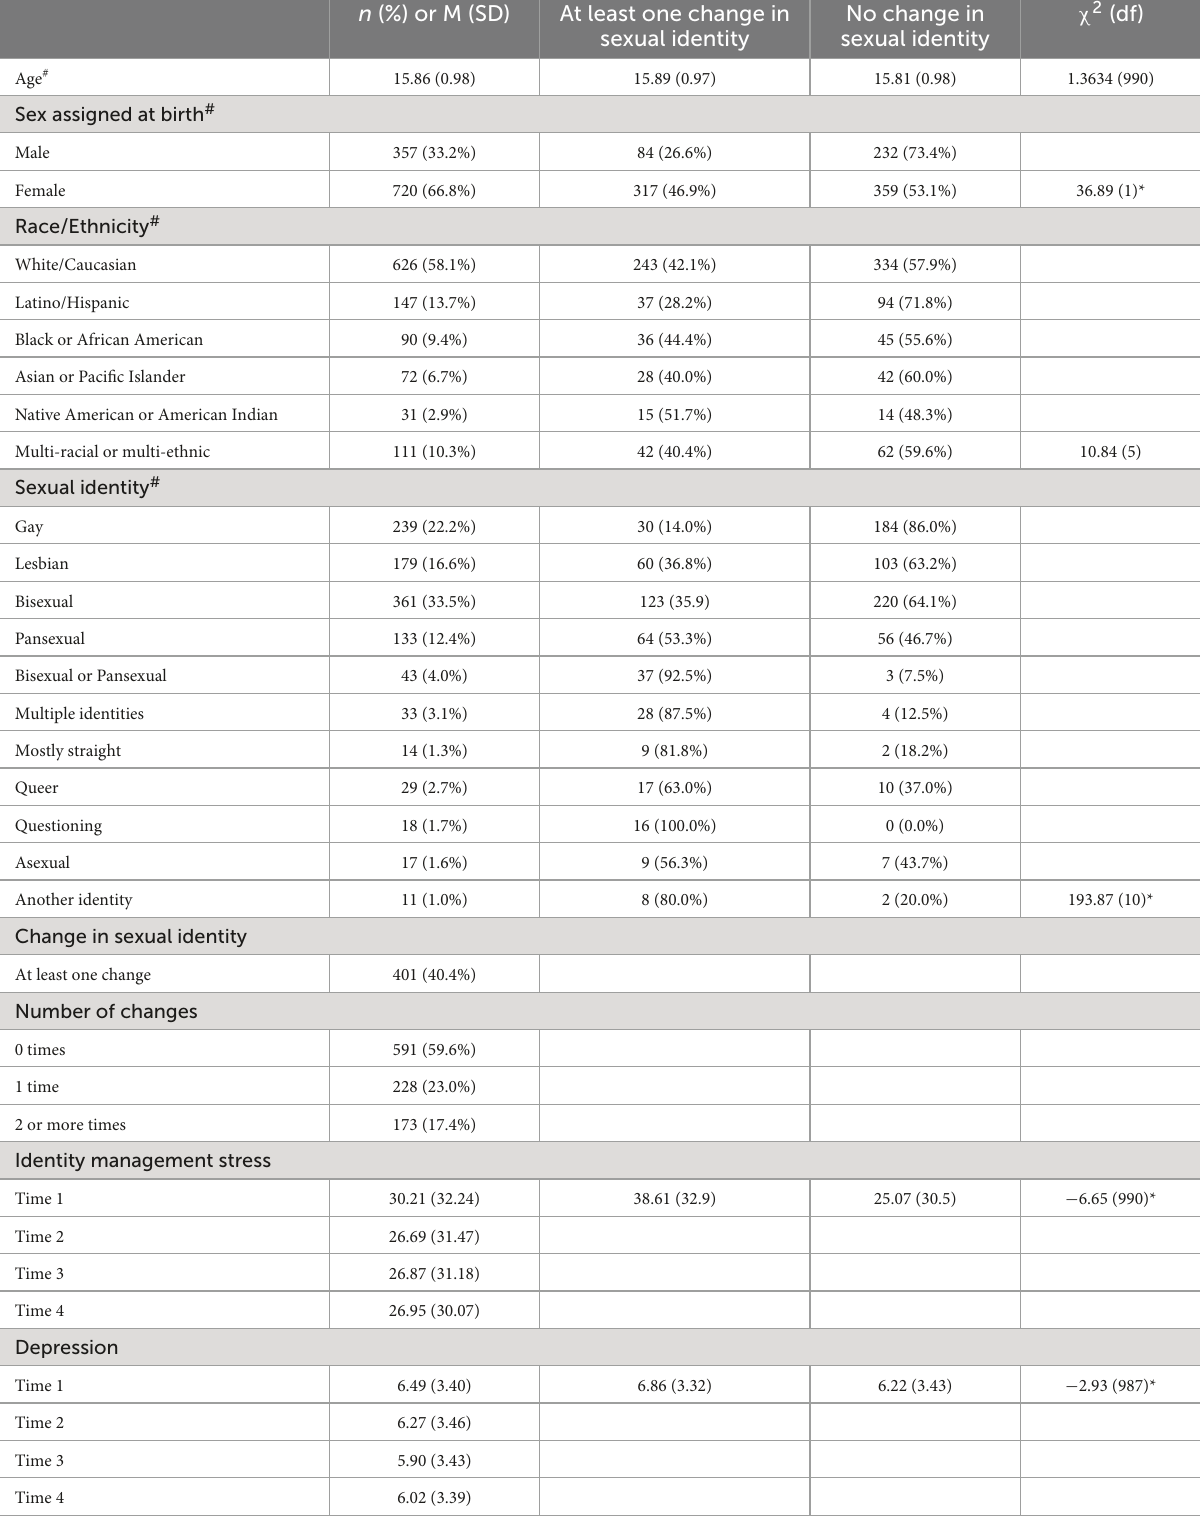
TABLE 1 Participant characteristics ( N = 1077; at